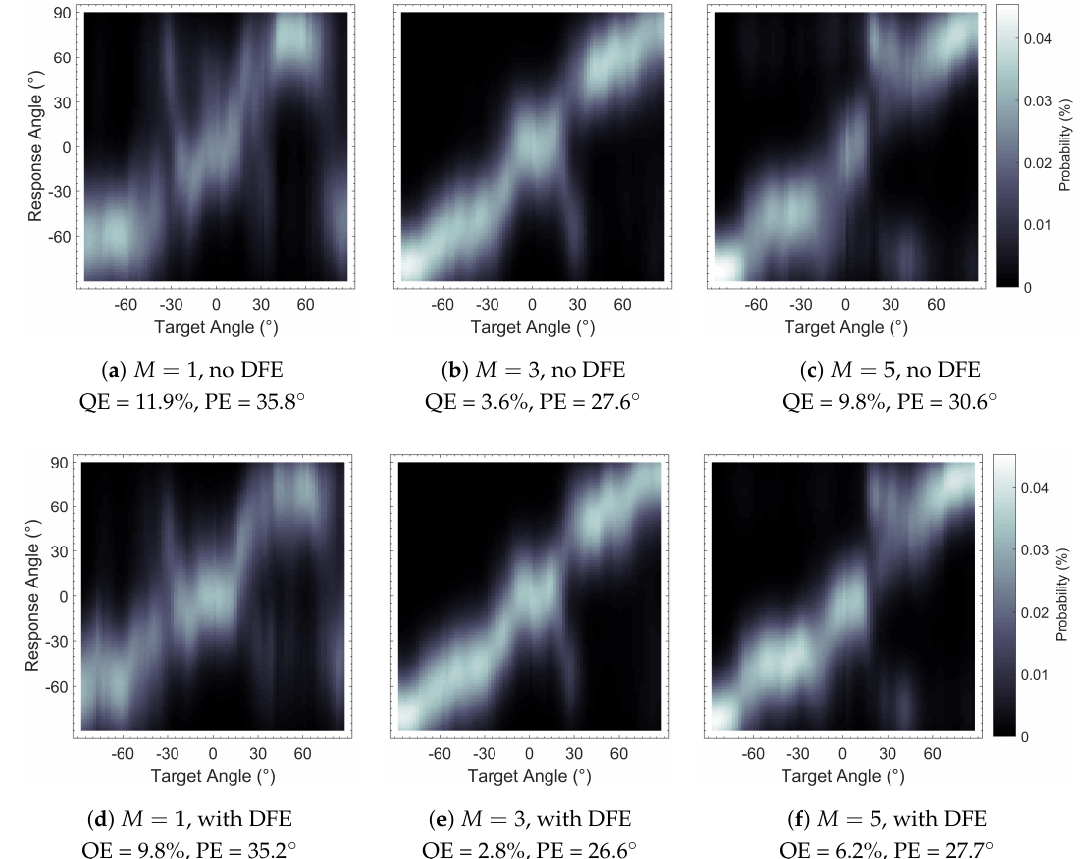
Figure 7. Sagittal Plane Localisation Model [44] plots of binaural Ambisonic rendering, with and without Diffuse-Field Equalisation (DFE): ( a ) M = 1, no DFE, ( b ) M = 3, no DFE, ( c ) M = 5, no DFE, ( d ) M = 1, with DFE, ( e ) M = 3, with DFE and ( f ) M = 5, with DFE. Plots show greater clarity (bolder shading) with DFE implementation.